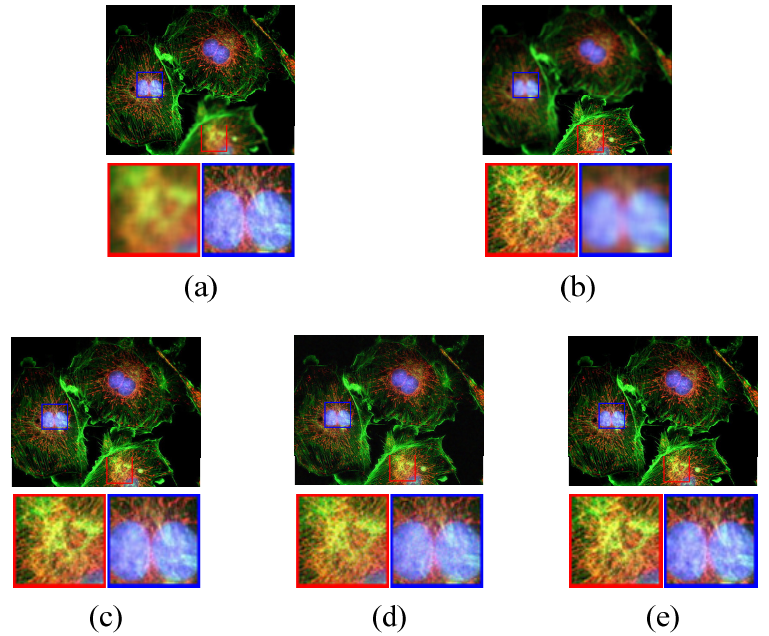
Figure 7. Fusion Results of Multi-focus Fluorescence Image - 2, ( a , b ) are source images, ( c – e ) are fused image of KSVD, JPDL, and proposed method